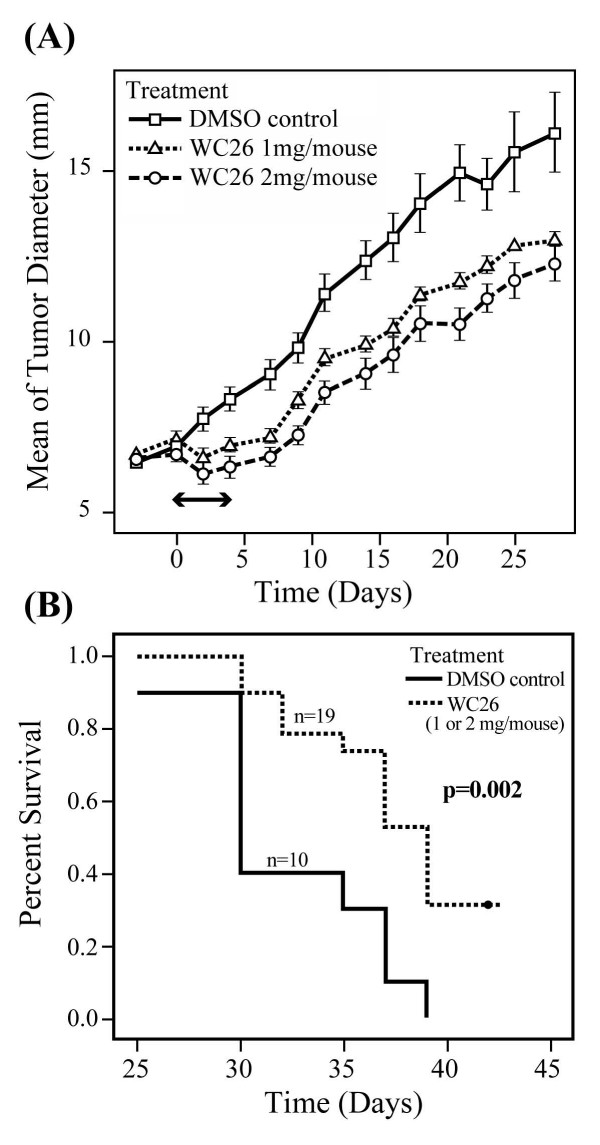
Systemic administration of sigma-2 receptor ligand slows tumor growth and improves survival. Mice with established pancreas tumors were treated with 5 days of WC26 in one of two dose ranges (2 mg/day, n = 9; Dash line or 1 mg/day n = 10; dashed line) or vehicle control (20% DMSO n = 10; solid line). (A): Mice treated with WC26 had smaller tumors compared to animals vehicle control (p < 0.0001). The two treatment groups were not statistically different. The double-headed arrow denotes the treatment period (5 days). (B): Survival of mice treated with WC26 compared favorably to the mice treated vehicle control (p= 0.002). Survival endpoints were defined as tumor diameter >15 mm or tumor ulceration.